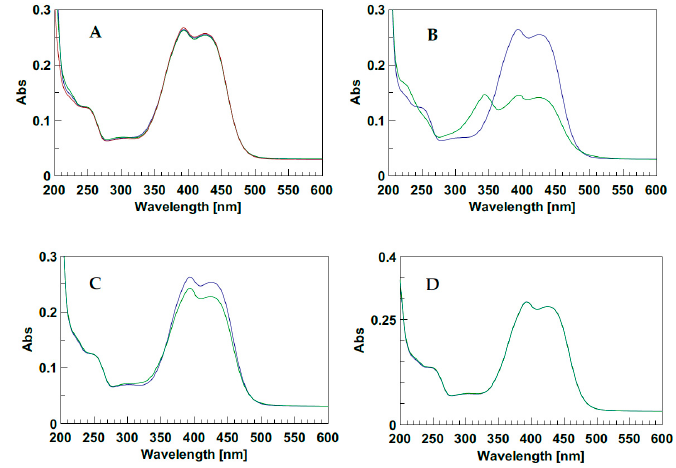
Figure 2. ( A ) UV spectra of d 1RR in the dark at different pH: Red pH = 5.7; blue pH = 7.0; green pH = 8.0. ( B – D ) UV spectra before (blue line) and after (green line) irradiation with LED at 435 nm (1 min, 1 LED), at pH = 8.0, 7.0, and 5.7, respectively.